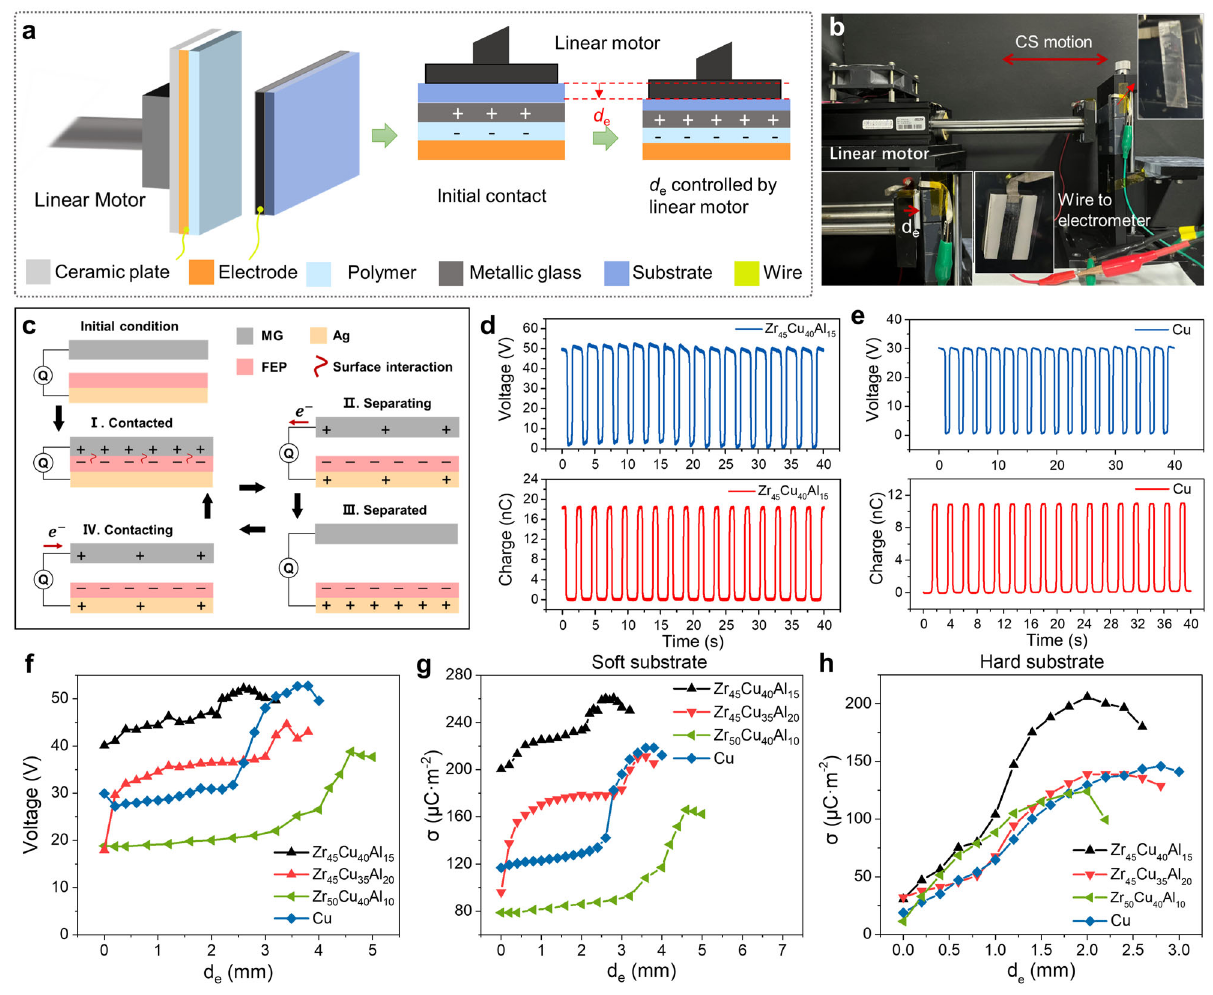
Fig. 2 | Performance evaluation of CS mode TENG. a Schematic diagram of the experimental setup. b Photograph of the device and experiment platform. c OperationalmechanismoftheMG-basedTENG.Voltage(up)andcharge(bottom) output of CS mode TENG with d Zr 45 Cu 40 Al 15 (5mm×15mm) and e Cu (5mm× 15mm) as the metal contacting with FEP fi lm. f V OC versus d e of different